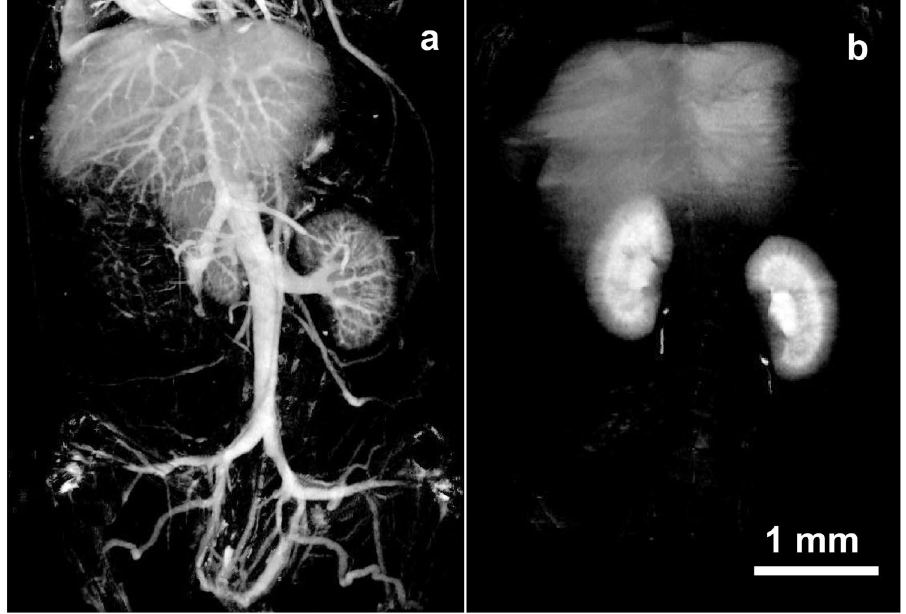
Figure 4. MicroCT coronal views of mouse 30 min after IV injection of INP ( a ) or Iohexol ( b ) (Both with 1.75 g I/kg IV injection). Vascularization is clearly seen at this time with the INPs.